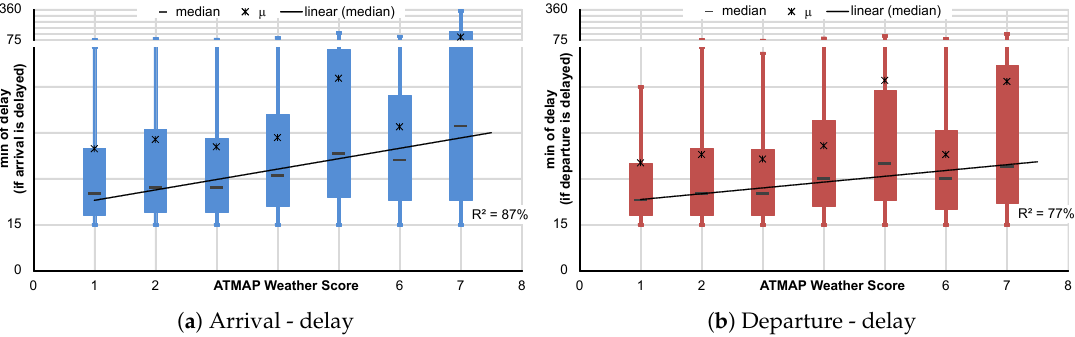
Figure 5. Quantification of ( a ) arrival and ( b ) departure delay if aircraft are not on time (delay greater or equal than 15 min).